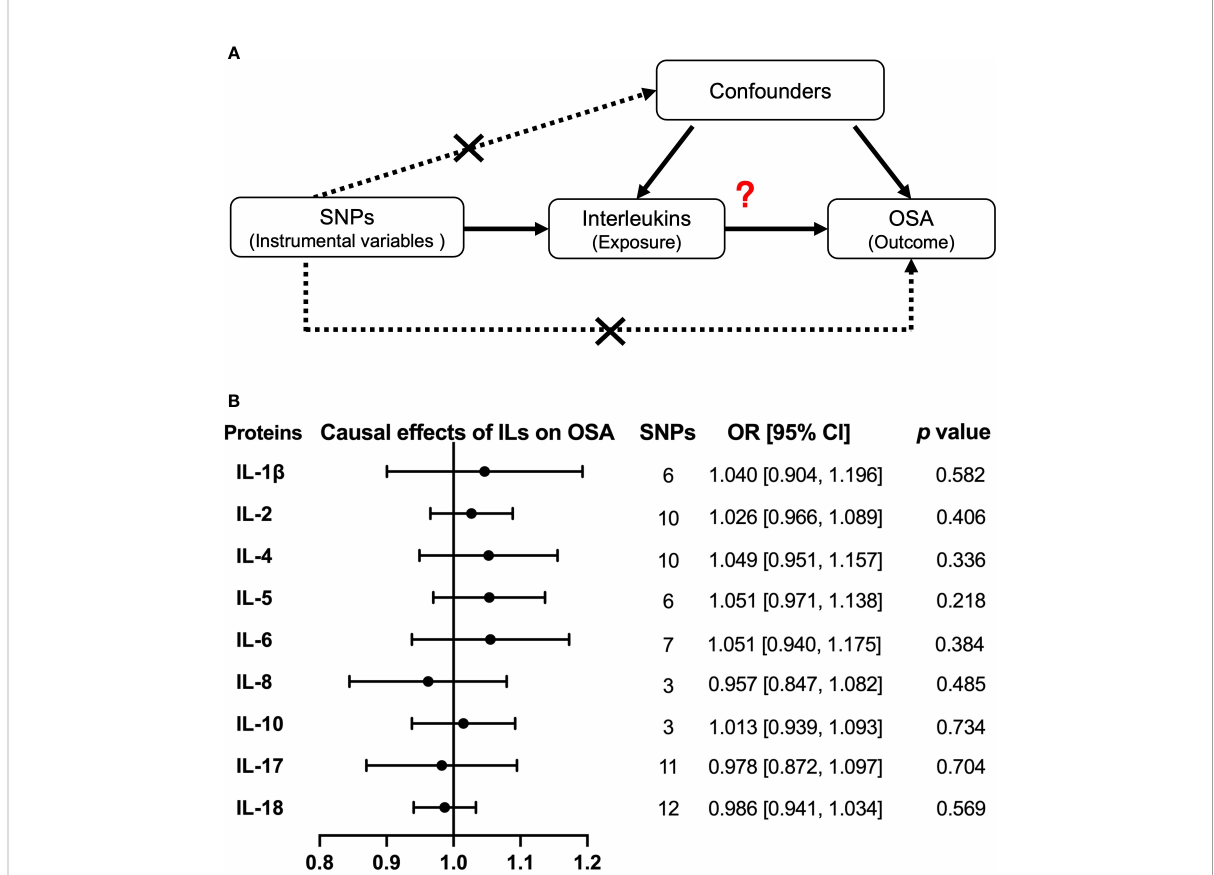
FIGURE 5 Causal relationships of interleukins on OSA risk by Mendelian randomization (MR) analysis. (A) The design of MR analysis was to explore the causal effects of interleukin levels on OSA risk: interleukins as exposure, OSA as outcomes, and SNPs independently associated with interleukins were used as instrumental variables. Other two assumptions are the same as described in the legend of Figure 4A. (B) The presented results were performed by method of inverse-variance weighting (IVW). IL,